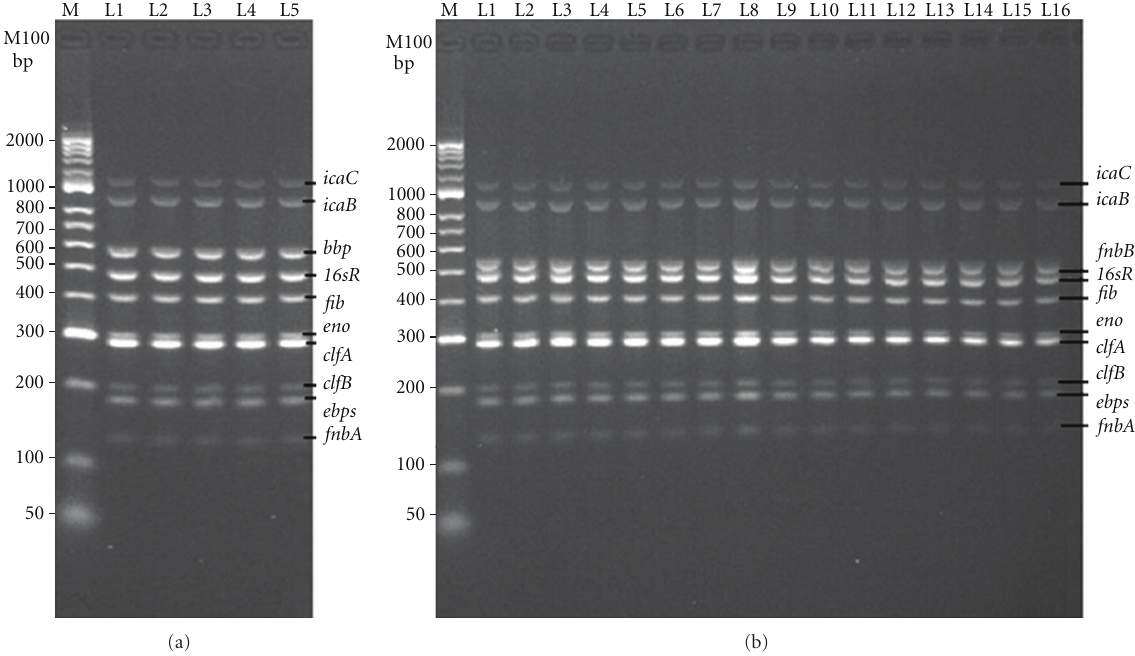
Figure 3: (a, b) Multiplex PCR amplification of MSCRAMMs and biofilm genes of MRSA and MSSA clinical isolates. (a) is related